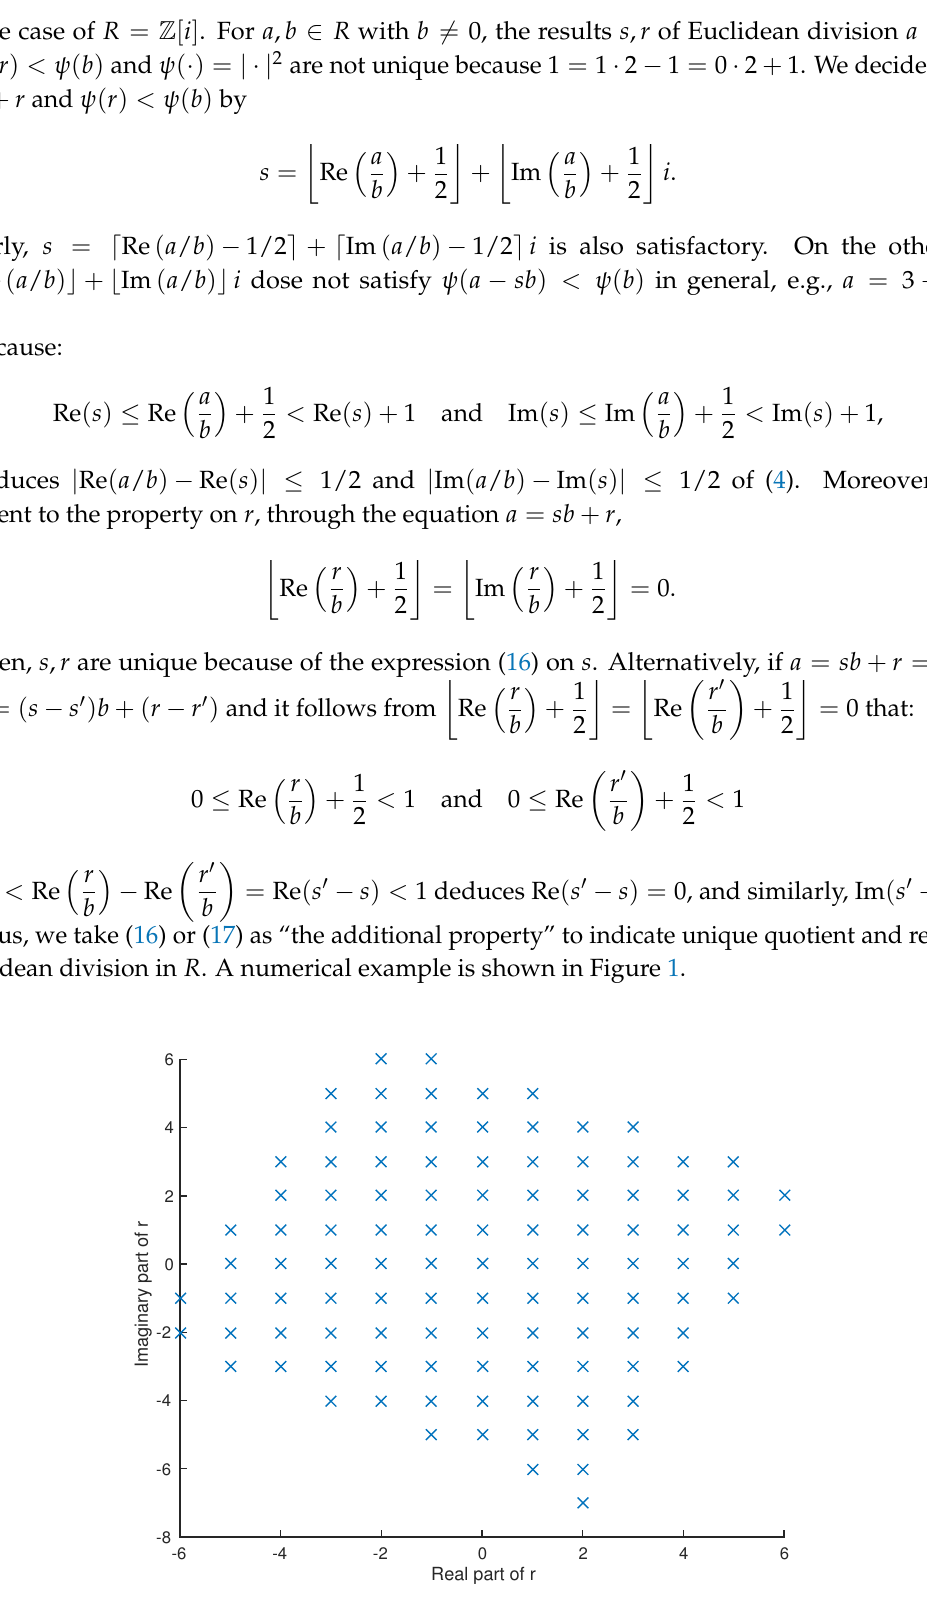
Figure 1. The remainders r of Euclidean division by b = 5 + 9 i in Z [ i ] . There are 5 2 + 9 2 = 106 = | b | 2 crosses, which can be all representatives of Z [ i ] / (cid:104) b (cid:105) , satisfying (17). If we adopt s with the ceiling function, then r = − 2 + 7 i is included instead of r = 2 − 7 i